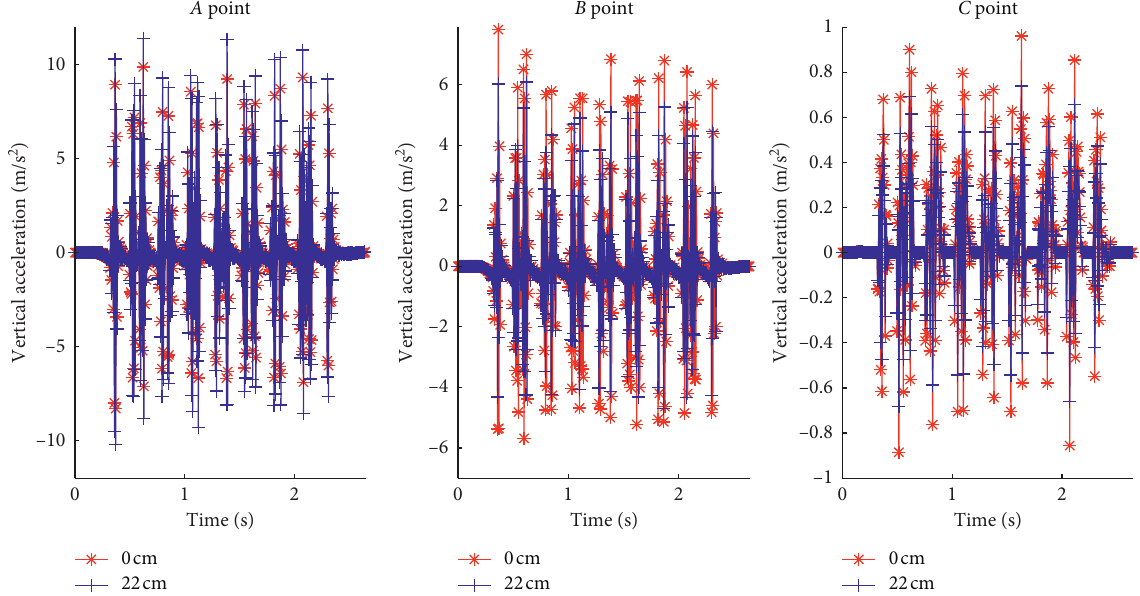
Figure 11: The simulated vertical acceleration with the thickness of 0cm and 22cm at the observation points A, B, and